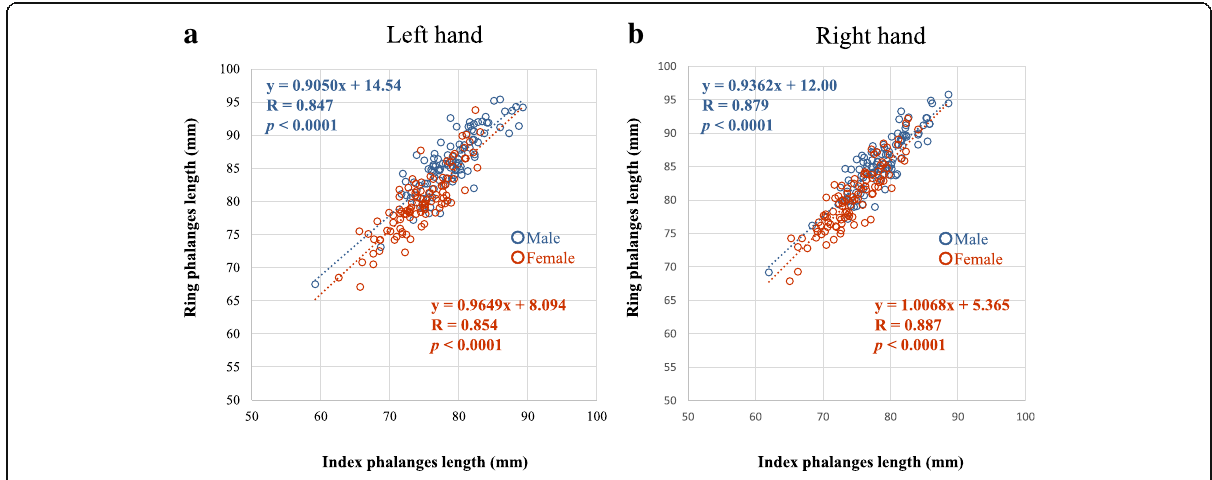
Fig. 2 Correlation between ring and index finger phalanx lengths in ( a ) the left hand and ( b ) the right